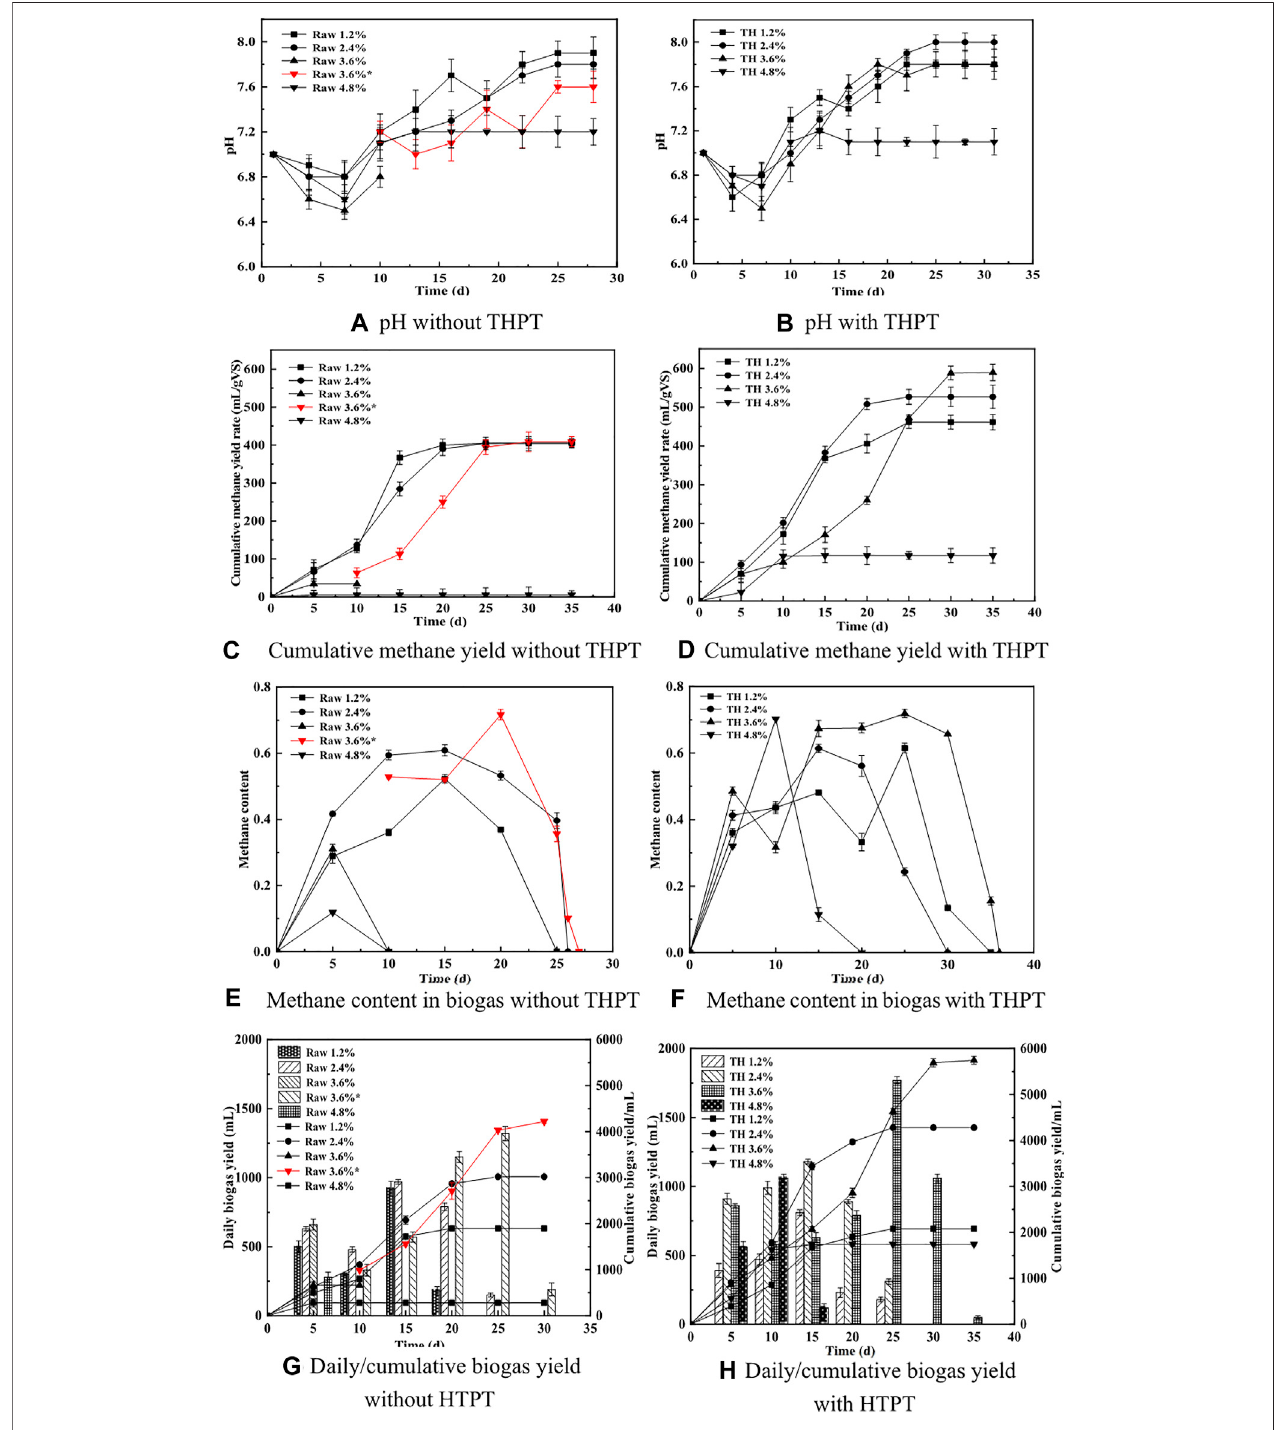
FIGURE 2 | Effects of THPT on the performances of batch AD of tofu. (A and B) The time-sequential changes of the pH value. (C and D) The cumulative methane yield. (E and F) The methane content in biogas. (G and H) The daily biogas/cumulative biogas yields, with and without THPT, respectively.